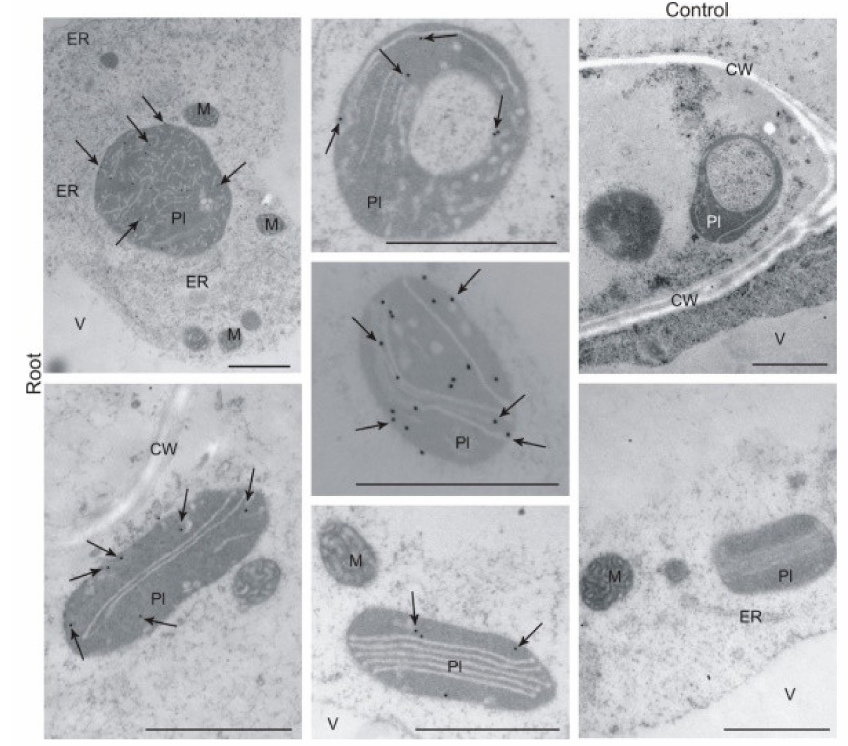
Figure 5. Localisation of BX1 by immunogold labelling and transmission microscopy in roots developed from seeds deprived of coleoptile 2 days after sowing (RDC) of rye inbred line L318. Abbreviations: CW—cell wall, ER—endoplasmic reticulum, M—mitochondrion, Pl—plastid, V— vacuole. Scale bars = 1 µ